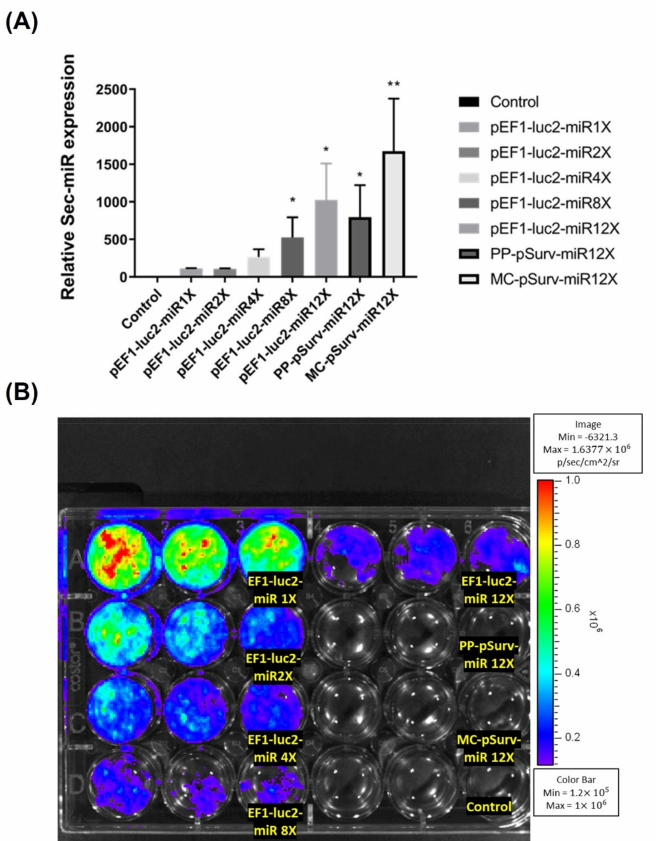
Figure 1. Sec-miR reporter expression from cells could be amplified by inserting multiple copies of Sec-miR into a single construct. Hela cells were transiently transfected with plasmids containing 1, 2, 4, 8, or 12 copies of Sec-miR driven by constitutive EF1 promoter or tumor-specific Survivin promoter (pSurv) in different wells. ( A ) All the Sec-miR expressions were normalized to the values in wells transfected with the 1X Sec-miR copy plasmid. Data are expressed as mean ± SD. Sec-miR expressions were detected in all the wells transfected with Sec-miR constructs; the Sec-miR expres- sions significantly increased as the copy numbers of Sec-miR increased in the plasmids. Moreover, Sec-miR expressions in the cells transfected with PP-pSurv-Sec-miR 12X-WPRE and MC-pSurv-Sec- miR 12X-WPRE were also compared. Sec-miR expressions of MC-transfected cells were significantly higher than PP-transfected cells and were comparable to the expressions detected in the cells trans- fected with pEF1-Luc2-Sec-miR 12X. ( B ) Bioluminescent signals emitted from cells transfected with different constructs were acquired after medium collection. *, p < 0.05; **, p <